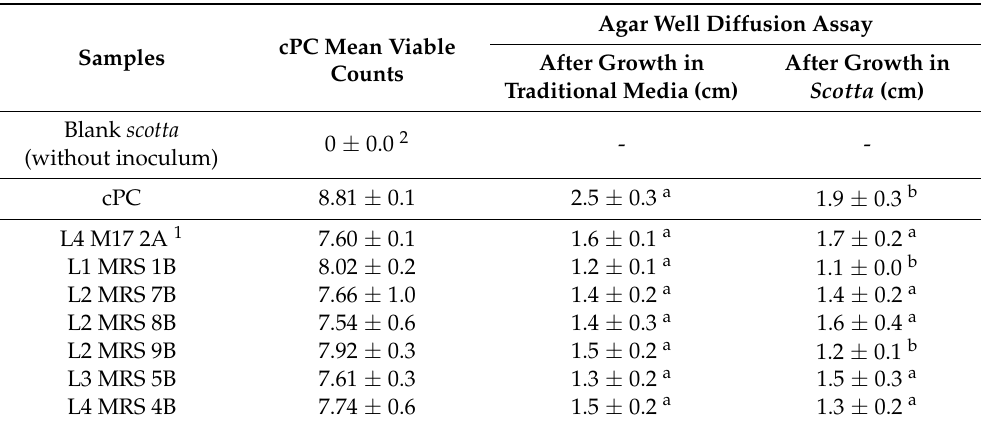
(log 10 CFU/mL ± standard deviation) of cPC and the 7 best-performing LABs after overnight growth in scotta . The third column shows results of AWDA: antilisterial activities in vitro (diameter of the inhibition halo) of cPC and LAB grown in traditional media and in scotta are compared.